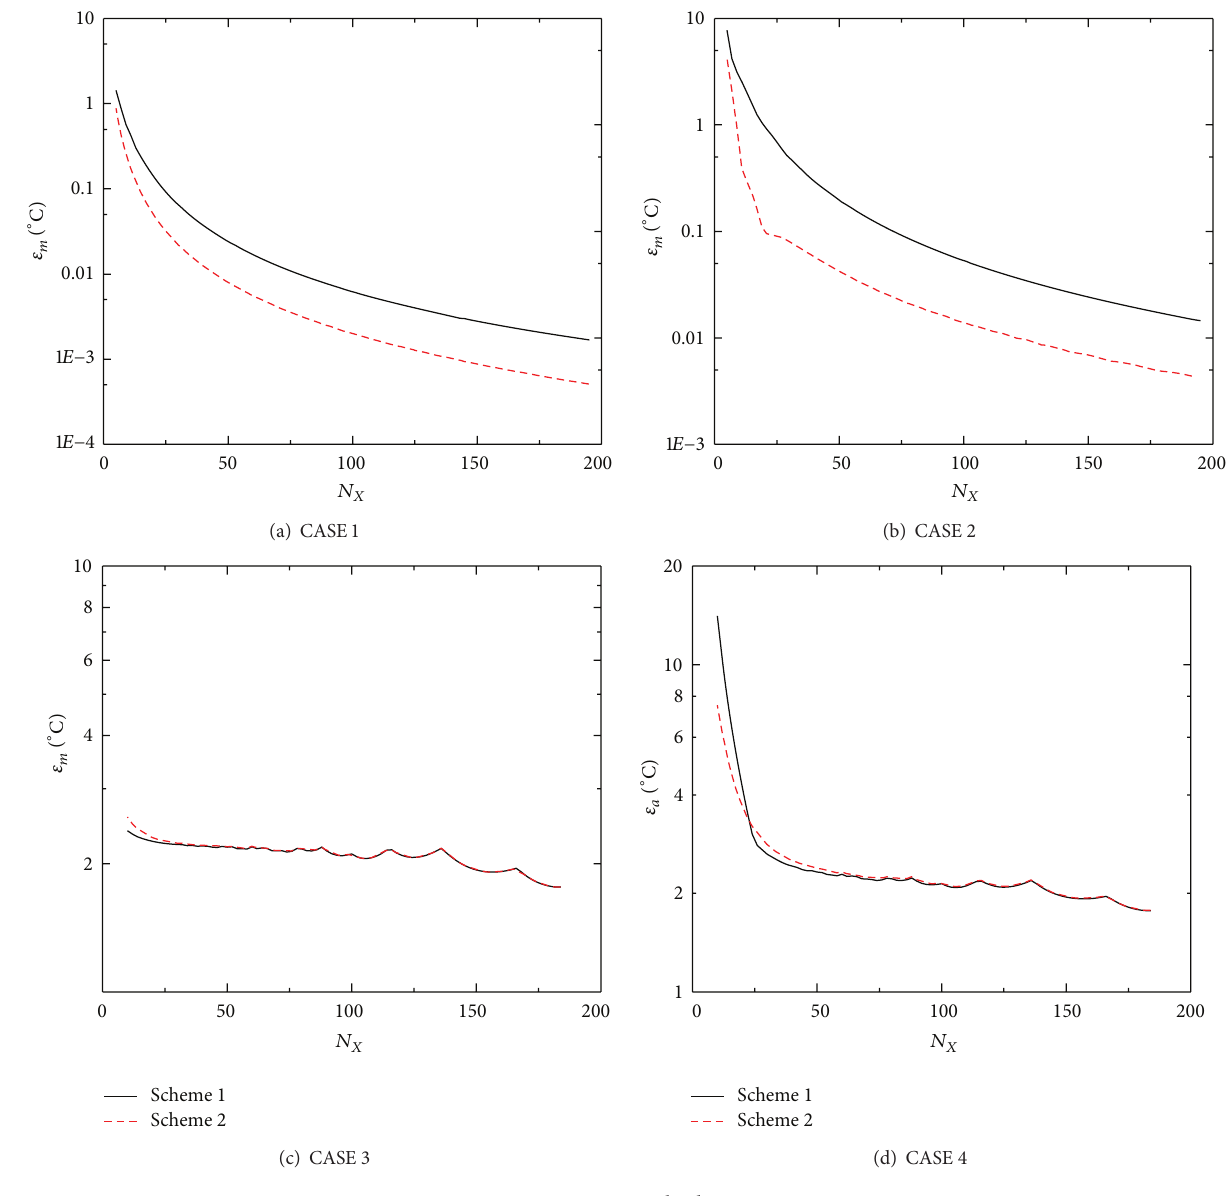
Figure 7: Maximum absolute